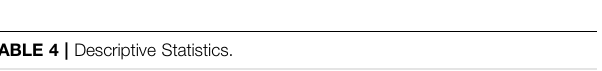
TABLE 4 | Descriptive Statistics.